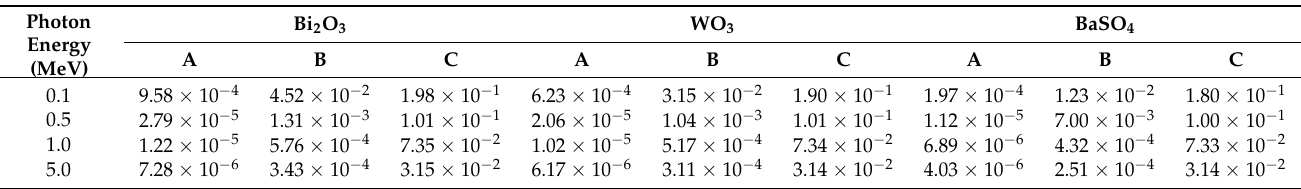
Figure 7. The µ values of Bi 2 O 3 /PVA, WO 3 /PVA, and BaSO 4 /PVA hydrogels containing varying filler contents of 0–40 wt.%, determined at photon energies of ( a ) 0.1 MeV, ( b ) 0.5 MeV, ( c ) 1 MeV, and ( d ) 5 MeV using XCOM. Table 5. Mathematical constants (A, B, and C) for µ in the form µ = A x 2 + B x + C (Equation (6)), determined from Figure